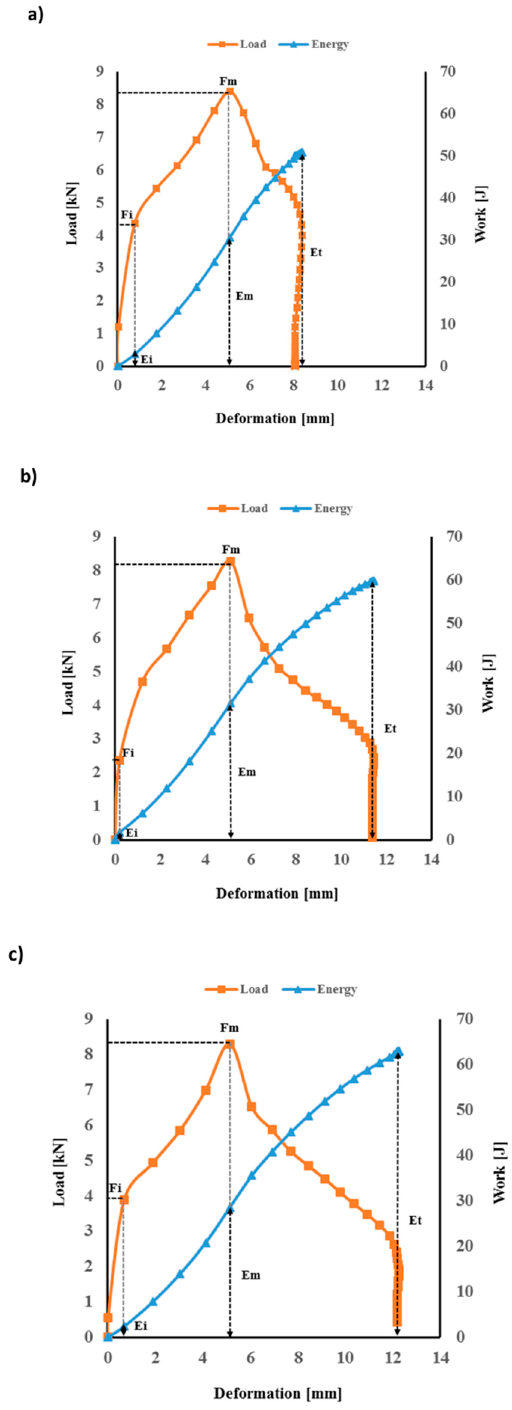
Figure 6. Load and work vs. deformation for flax / VE / basalt hybrid composites: ( a ) flax 50 J, ( b ) flax 60 J, and ( c ) flax 70 J. FM, load maximum; FI, incipient damage load; EM, energy maximum; EI, incipient damage energy; ET, energy total.